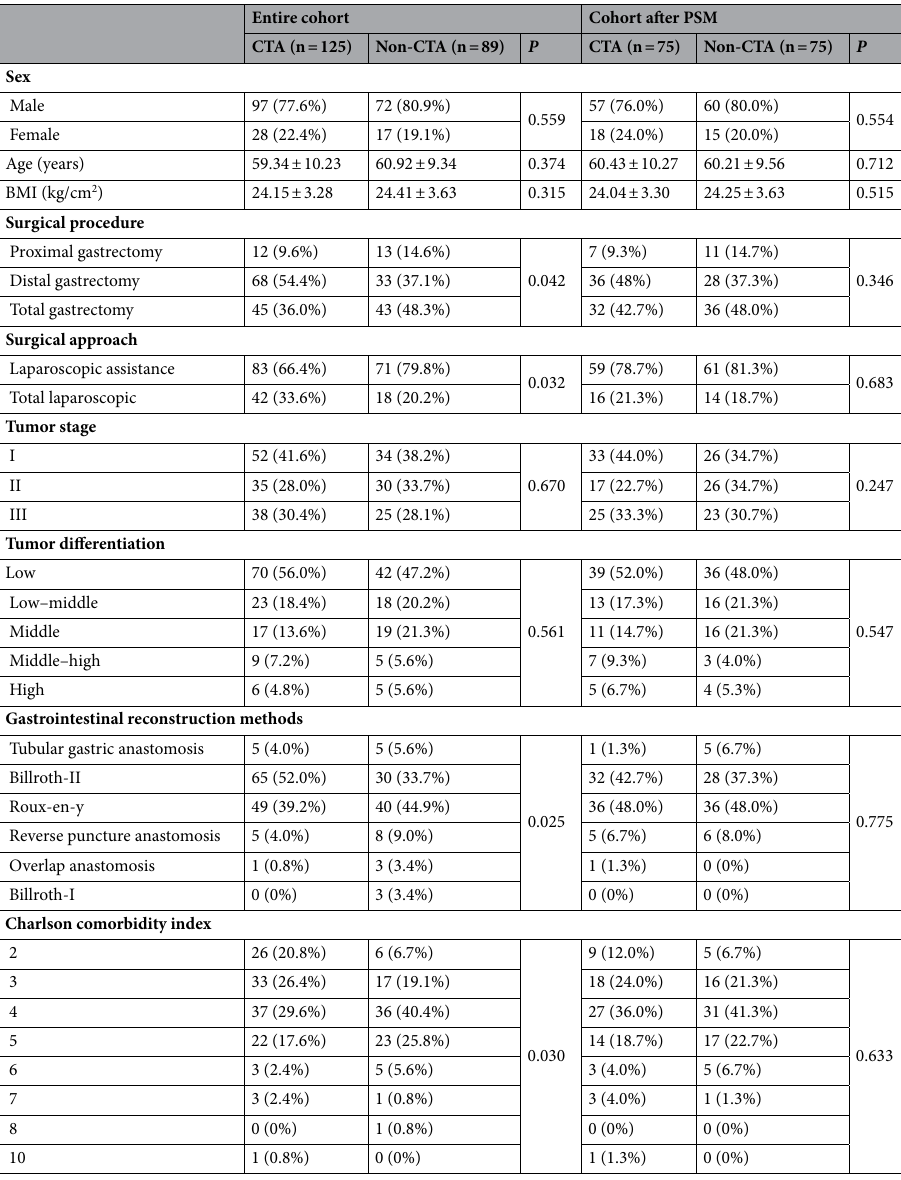
Table 1. Basic characteristic data of total gastric cancer patients and gastric cancer patients after